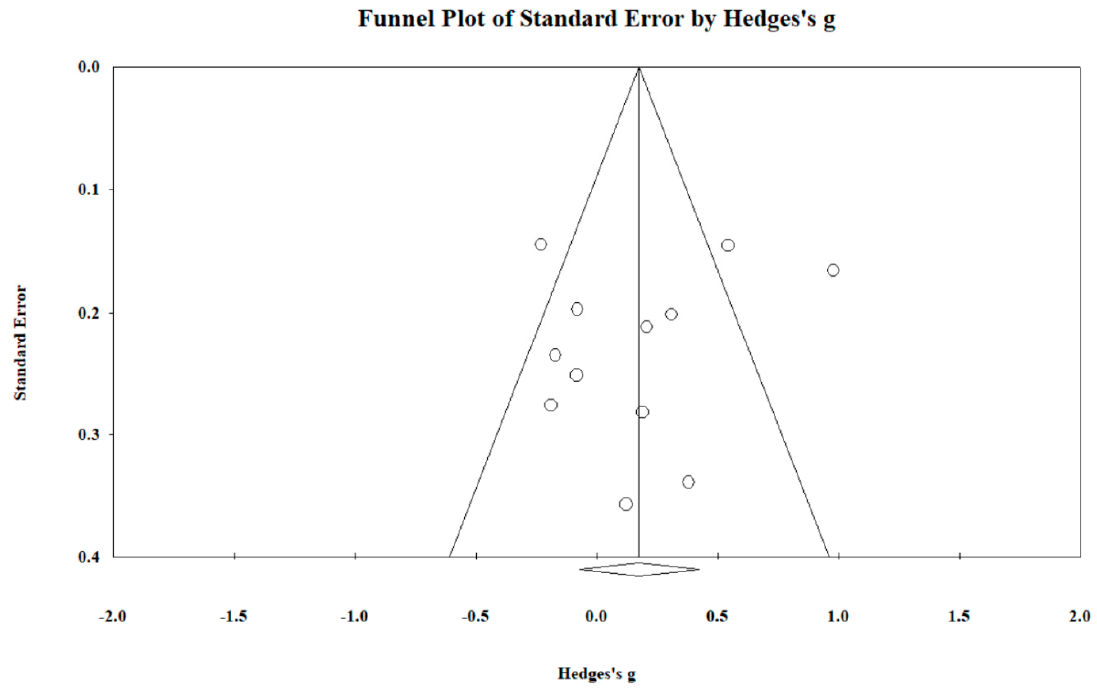
Figure A3. Funnel plot of Hedges’ g vs standard error for incongruent stimuli.